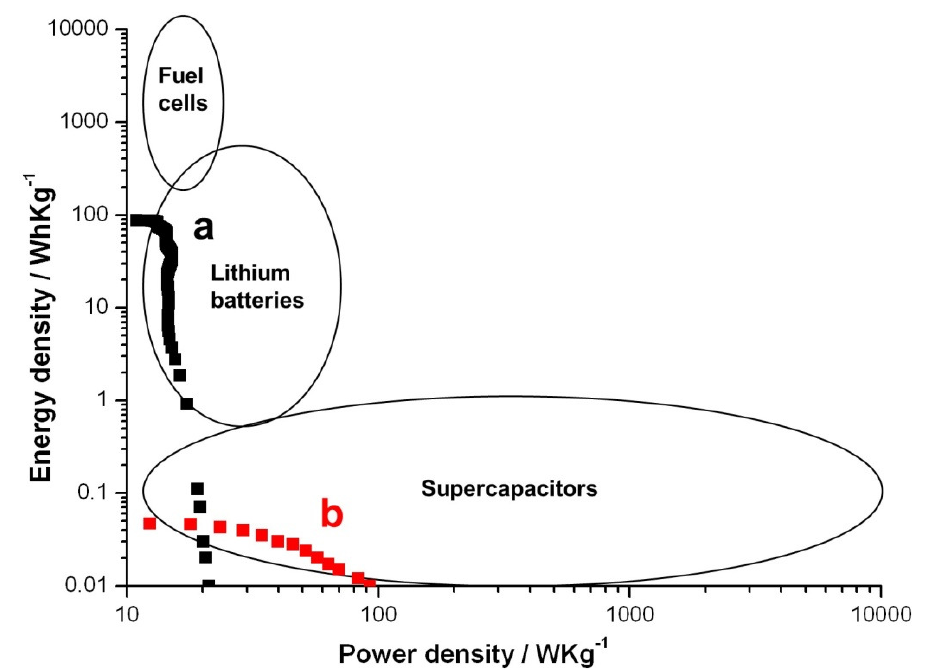
Figure 4. Ragone plots of the textile batteries when discharged at ( a ) 1/6 C and ( b ) 4 C when using the PEDOT textile battery as a primary